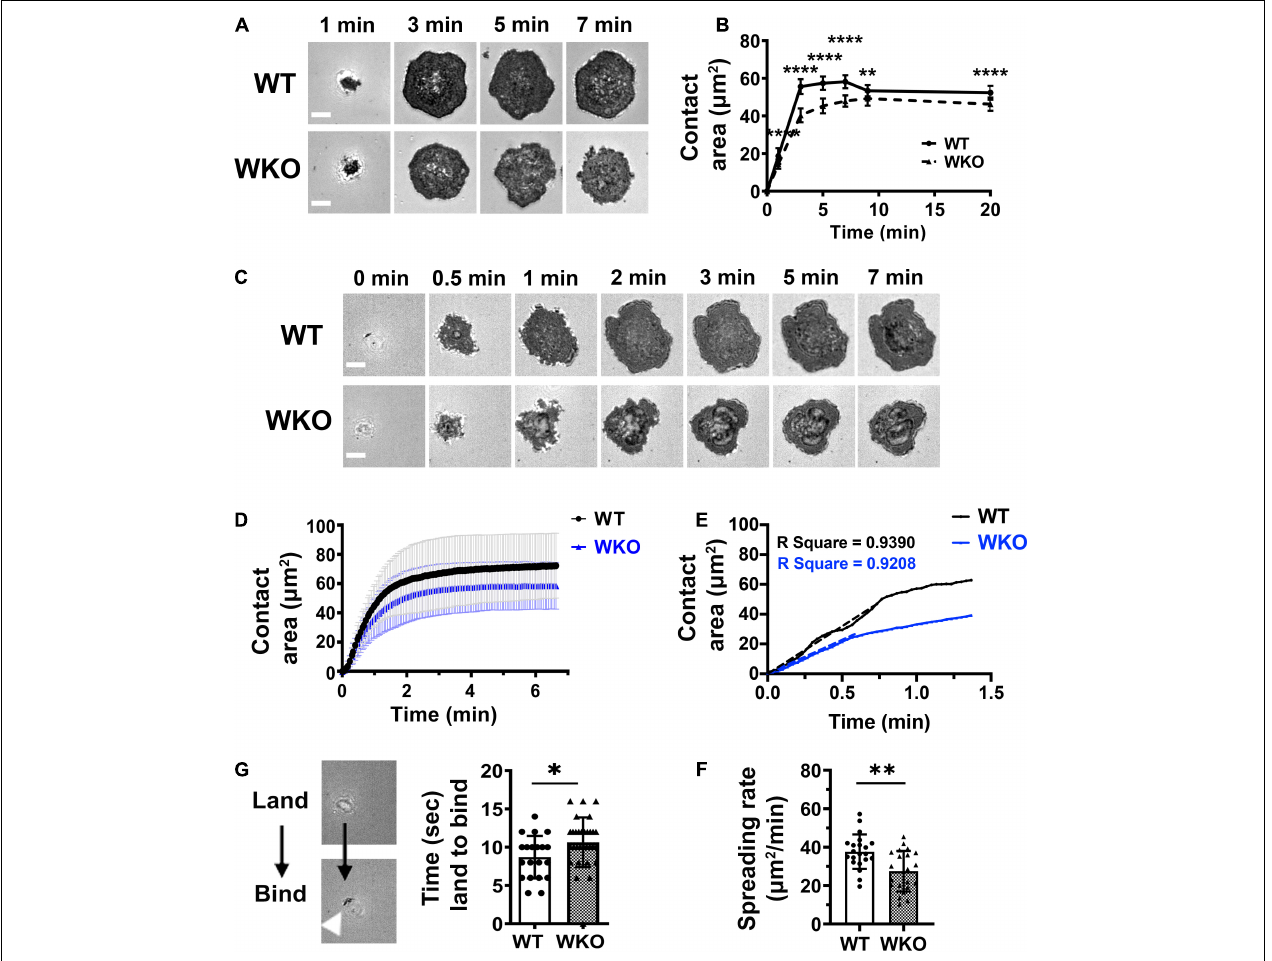
FIGURE 2 | WASp contributes to GCB spreading on Fab’-PLB. GCBs isolated from SRBC-immunized mice were incubated with Fab’-PLB and either imaged after fixation (A,B) or live (C–F) by IRM. (A) Representative IRM images of WT and WKO GCBs fixed at indicated times. (B) Contact areas of fixed GCBs on Fab’-PLB over time were measured using NIH-ImageJ. The results were the average ( ± SD) of > 100 individual cells per condition from 7 independent experiments. (C) Representative time-lapse IRM images of WT and WKO GCBs. (D) Contact areas of WT and WKO GCBs over time using time-lapse IRM images and NIH ImageJ. The results were the average ( ± SD) of 20 ∼ 30 individual cells per condition from four independent experiments. (E) Initial spreading rates of individual GCBs were determined using the slopes of their contact area vs. time curves by linear regression. Shown is an example. (F) Spreading rates of WT and WKO GCBs on Fab’-PLB. (G) Representative IRM images (left panels) of a cell that just landed on (white shadow) or started binding (dark spots) to Fab’-PLB. The time between cell landing on and binding to Fab’-PLB (right). Data points represent individual cells. Shown are the averages ( ± SD) of 20 ∼ 30 individual cells for each condition. n = 4. Scale bars, 3 µ m. * p < 0.05, ** p < 0.01, and **** p < 0.0001, unpaired Student’s t -test or one-way